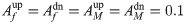
Stability and competition in the NMDAR-based model.A. Fixed points of ⟨w⟩ as functions of the ratio between the maximum potentiation and depression parameters. When A+/A− is smaller than 0.042, two nontrivial fixed points exist. At higher values, they collide and disappear. B. The w-dependent drift at the stable fixed point, as a function of A+/A−, which changes sign at A+/A− = 0.025. In the dark gray region, a stable fixed point exists and the w-dependent drift is negative. In the light gray region a stable fixed point exists and the w-dependent drift is positive, and in the white region there is no stable fixed point. C-E. The average drift when A+/A− is 0.01, 0.03 and 0.05, respectively. Filled circles represent stable fixed points and the open circle an unstable fixed point. The gray shading is the result of simulations, and the solid curve is the analytical result. F-H. The steady-state distributions corresponding to the parameters in C-E. I-K. Synaptic competition between correlated and uncorrelated synapses corresponding to the parameters in C-E. Parameters are Afup=Afdn=AMup=AMdn=0.1, and the time constants are as in Table 2.